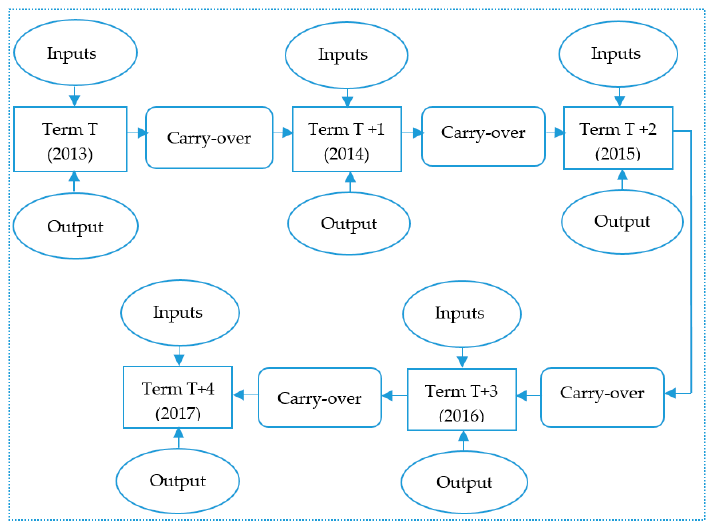
Figure 2. Dynamic structure among link, inputs, and